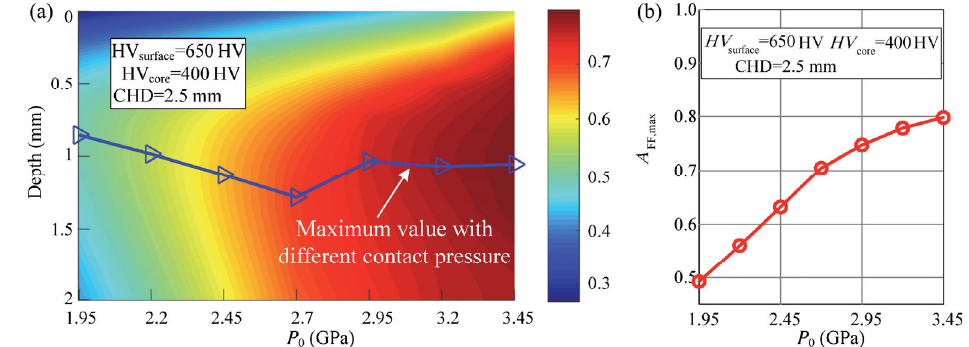
Fig. 16 Distribution of